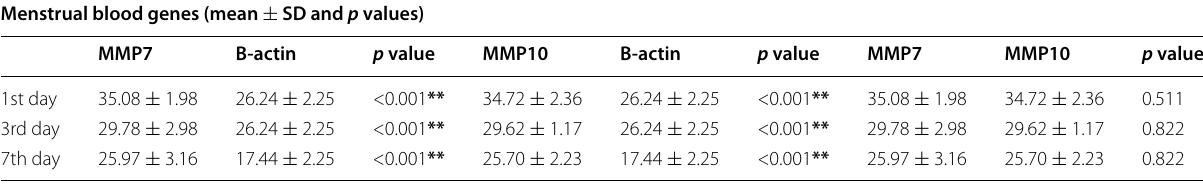
Paired t test (* P is significant if < 0.05, ** P is highly significant if < 0.01)